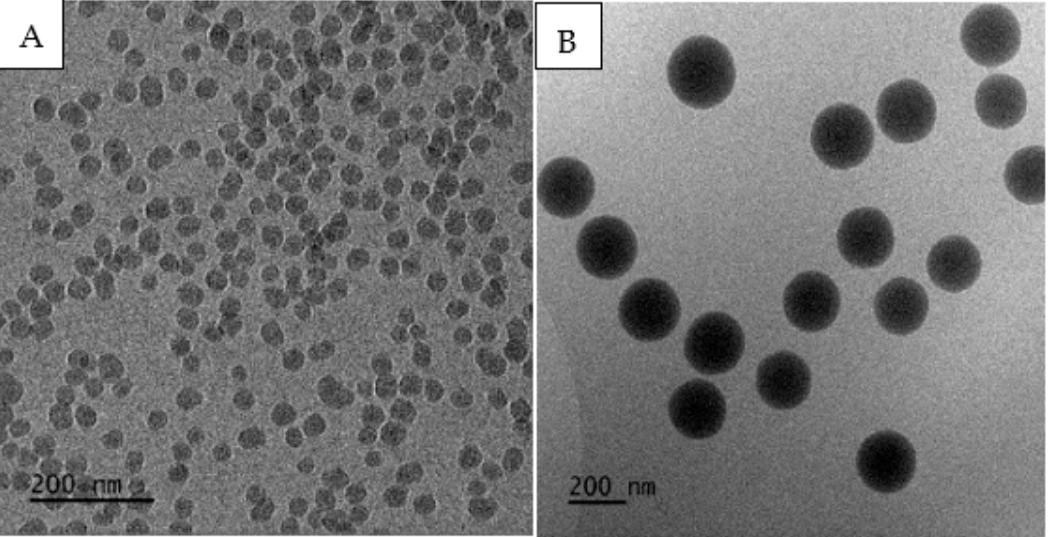
Figure 4. Examples of TEM images with visible silica markers: solution R1 ( A ); solution R2 ( B ).